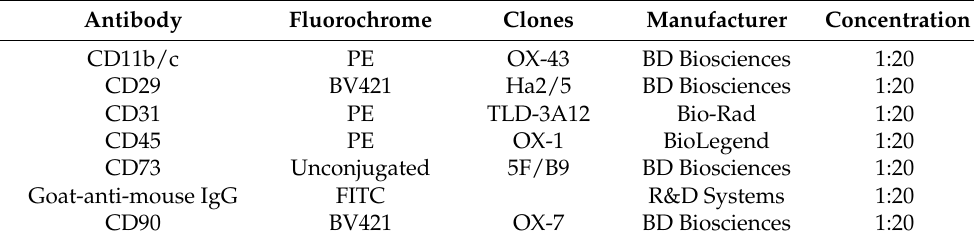
Table 1. Antibodies used for ISCT characterization, including fluorochromes, clones, and